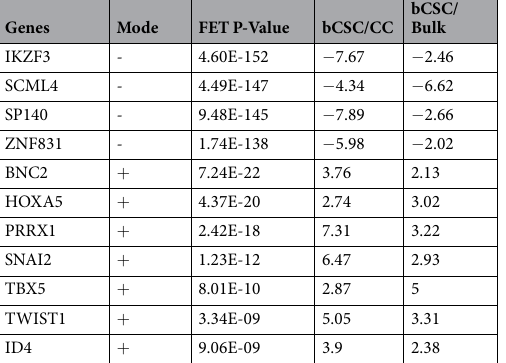
Table 1. bCSC specific Transcription Factors and Master Regulator. The 11 transcription factors differentially expressed and with the same pattern, up or down regulated, in both “bCSC/Bulk” and “bCSC/CC” datasets and selected as master regulators in the “bCSC/CC” dataset by MRA-FET. Mode = Positively ( + ) or negatively ( − ) correlated with the bCSC phenotype, FET p-Values = P value as possible Master regulator in MRA-FET analysis, bCSC/CC = Fold Change in the bCSC/CC dataset of the determined gene, bCSC/Bulk = Fold Change in the bCSC/Bulk dataset of the determined